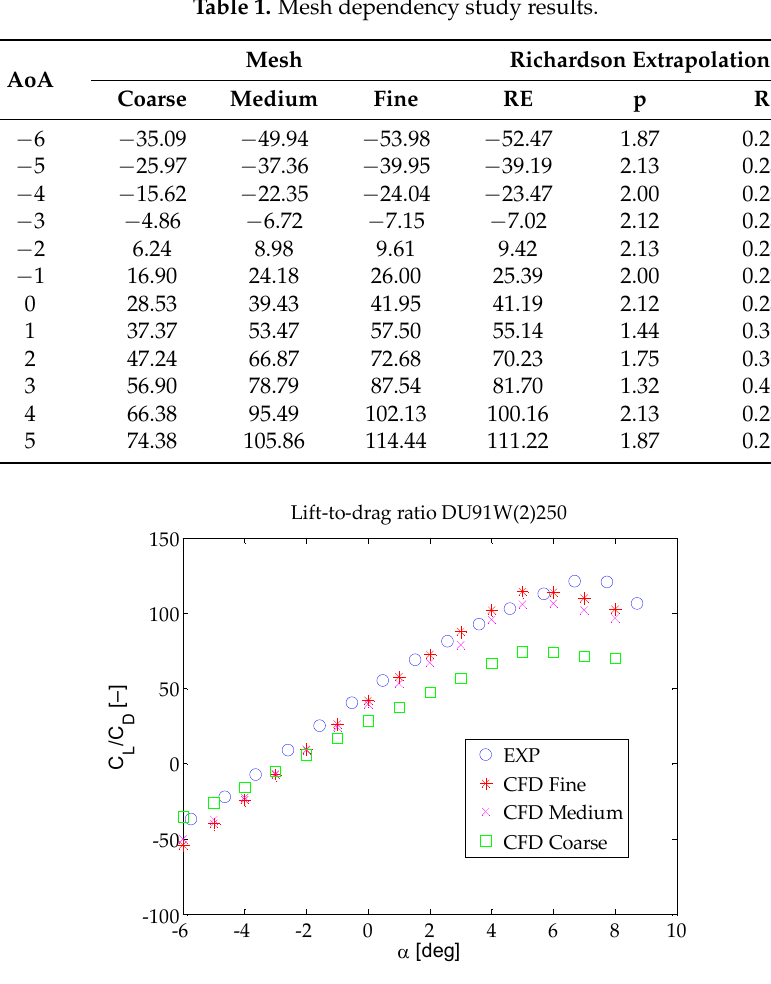
Figure 2. Results of the lift-to-drag ratio with each mesh level of the numerical simulations (CFD) vs. the experimental data of the DU91W(2)250 clean airfoil without the implementation of any GF. Both lift and drag dimensionless coefficients were calculated with the Equations (1) and (2), Table 1. Mesh dependency study results.